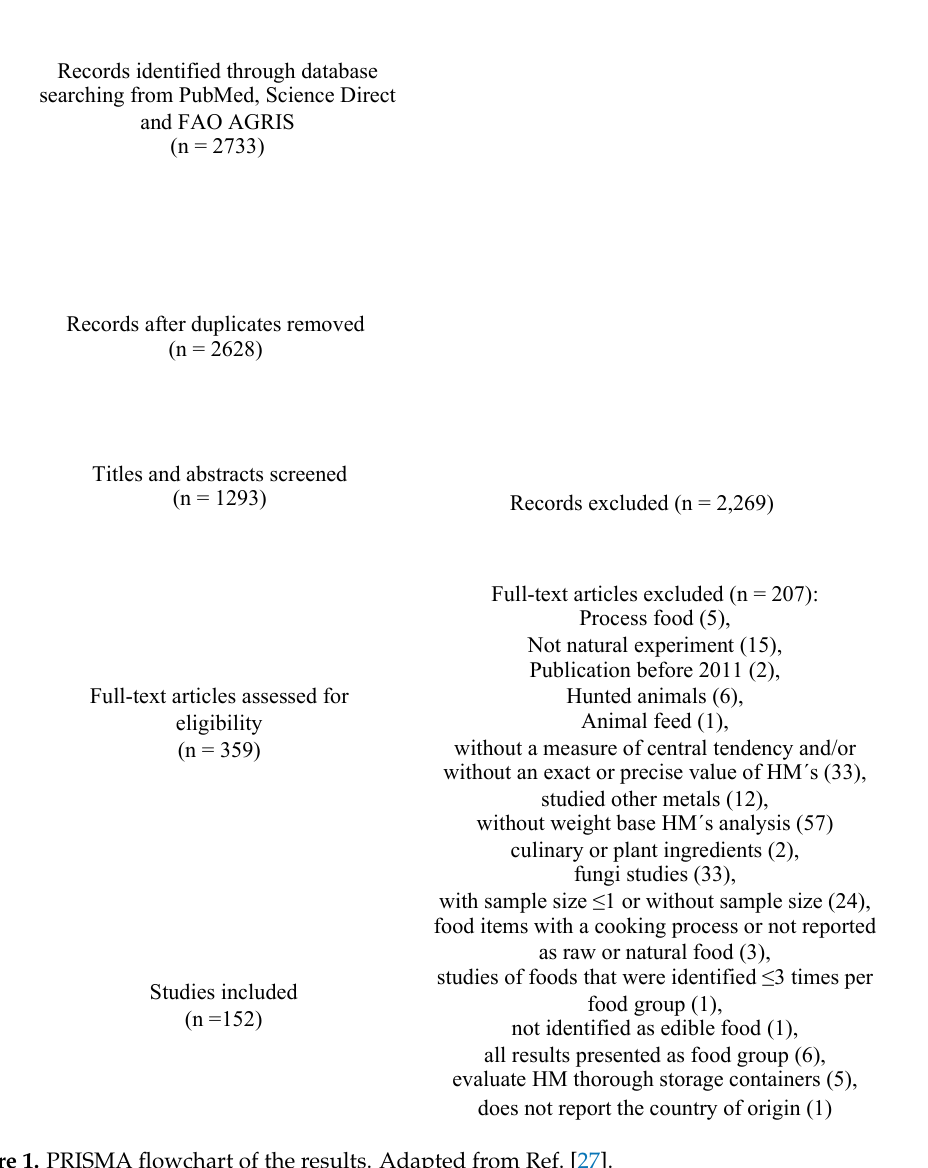
Figure 1. PRISMA flowchart of the results. Adapted from Ref . [27].